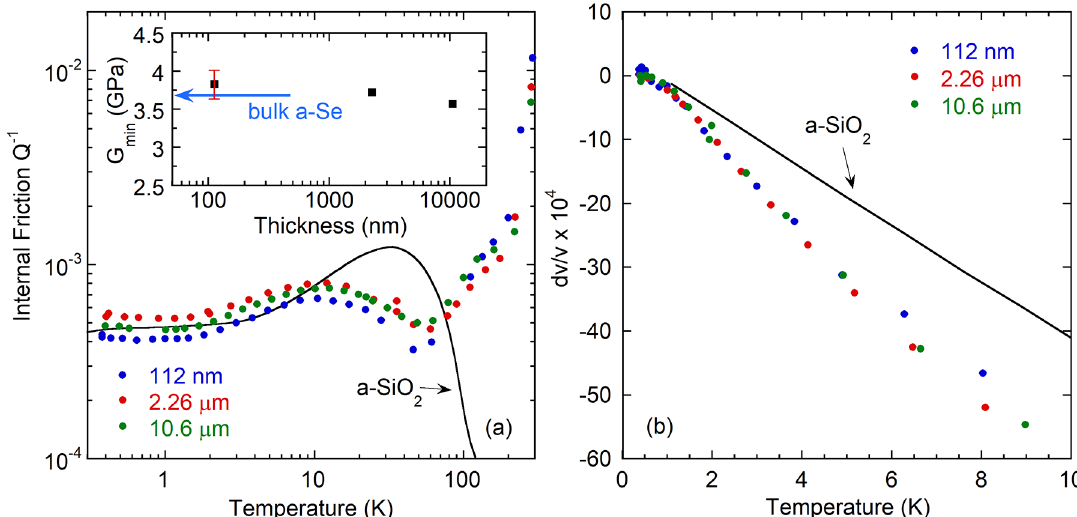
(b) of three a -Se films with different thicknesses. The data of 0